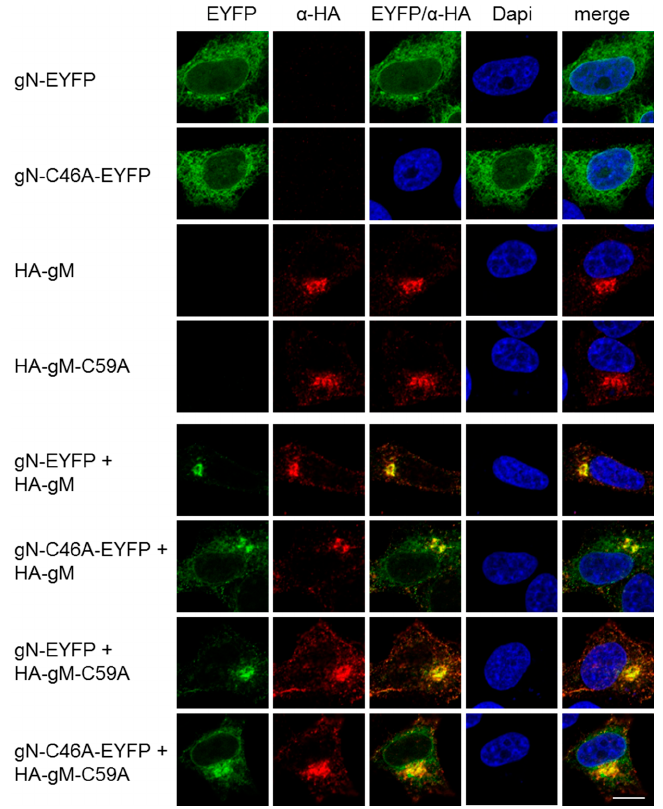
Figure 4. A non-covalent interaction of HSV-1 gN with gM is sufficient for its transport to the TGN. The subcellular localizations of gN–EYFP, gN–C46A–EYFP, HA–gM or HA–gM–C59A were analyzed